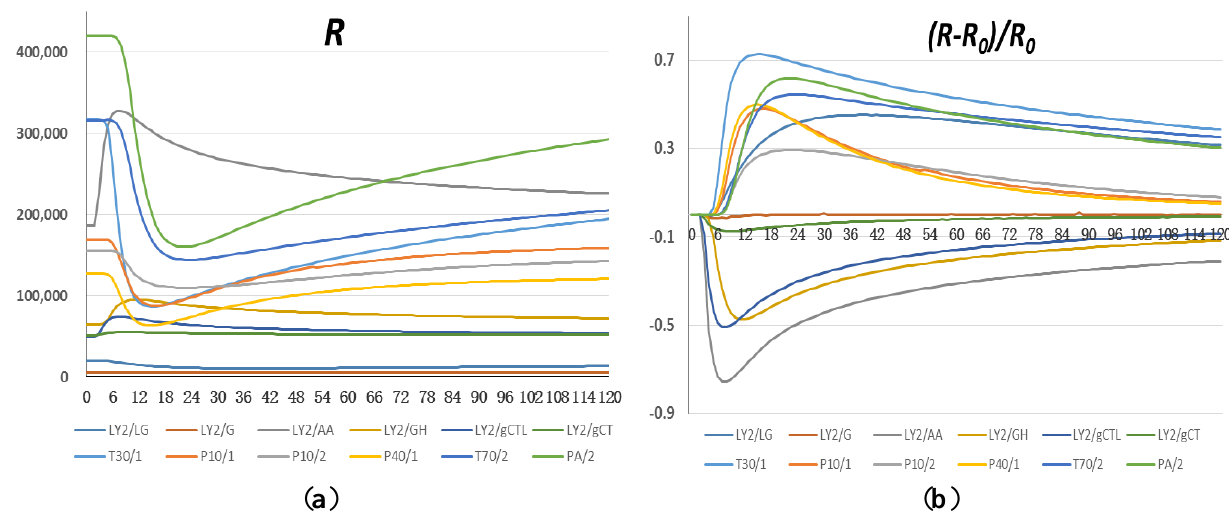
Figure 1. Sensor responses to refined oil. ( a ) Original sensor signals; ( b ) Sensor resistance